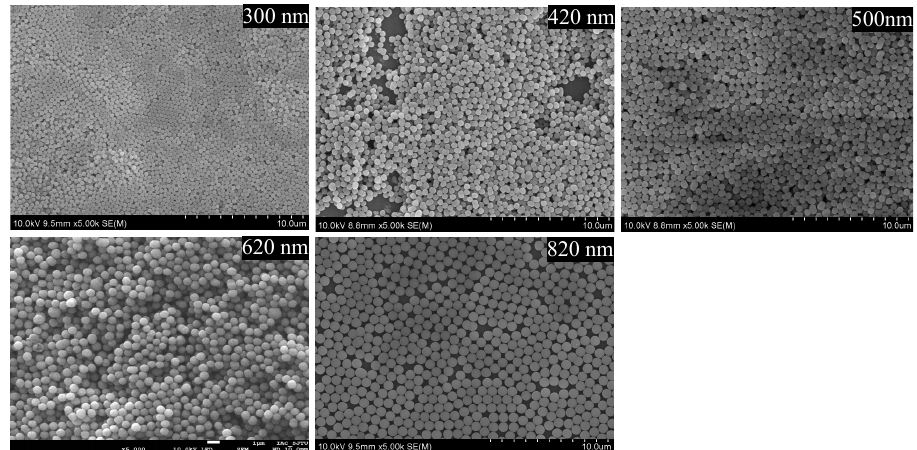
Figure 1. SEM images of synthesized SiO 2 particles with diameters of 300 nm, 420 nm, 500 nm, 620 nm, and 820 nm.